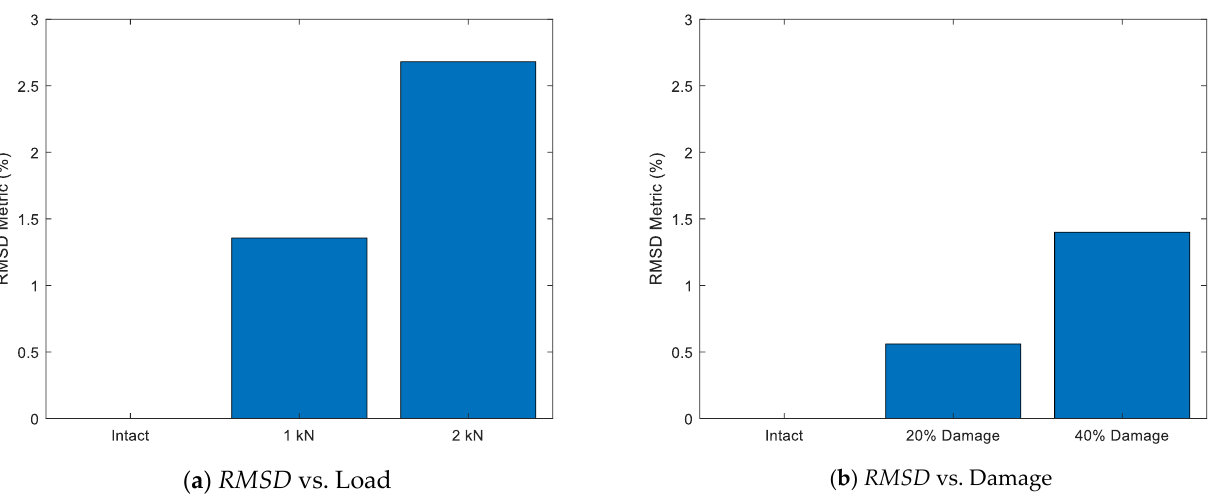
Figure 6. RMSD metric of numerical admittance responses under loading and damage cases.